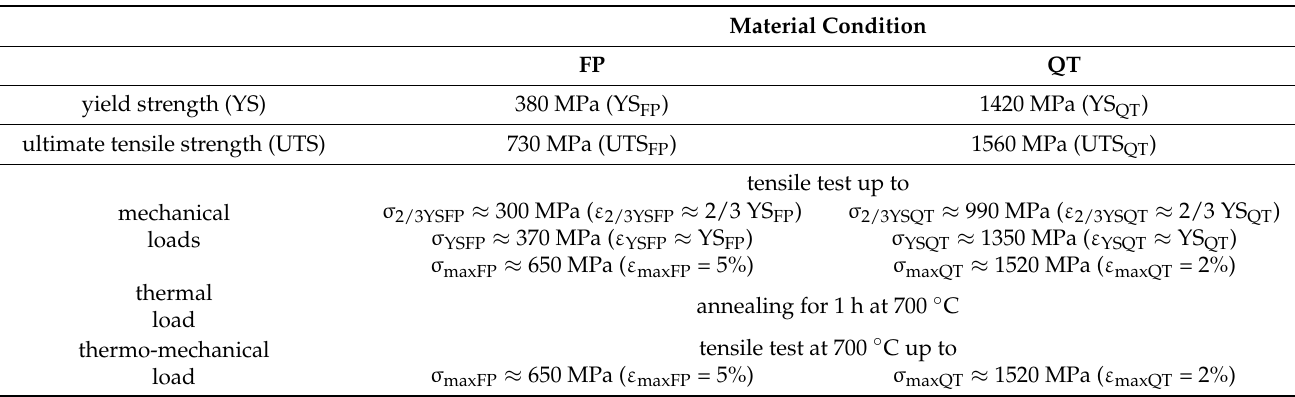
Figure 5. Results from tensile tests conducted on AISI 4140 in the two heat treatment conditions, FP and QT, with indicated chosen mechanical loads and the ultimate tensile strength (UTS FP and UTS QT ). Table 2. Mechanical properties of the material conditions and applied loads on the ground specimens in the thermal and mechanical testing